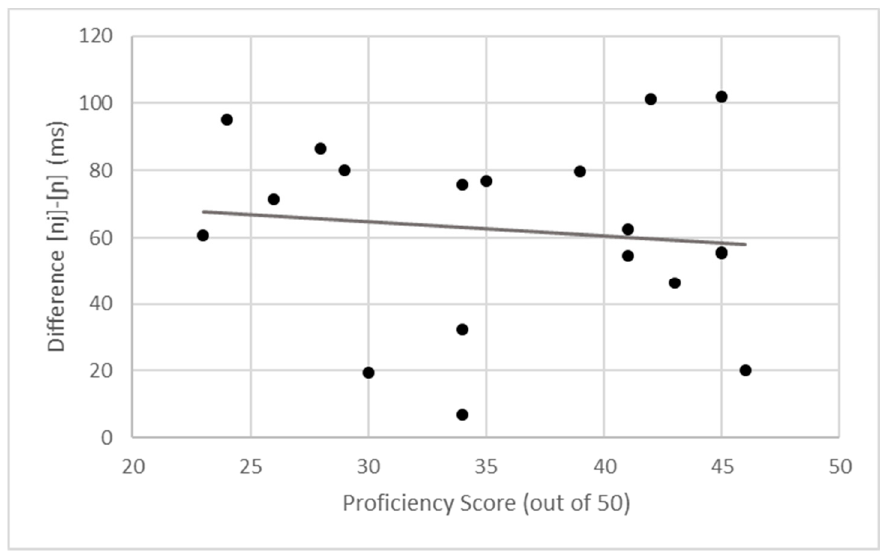
Figure 6. FV duration difference by Spanish proficiency score.